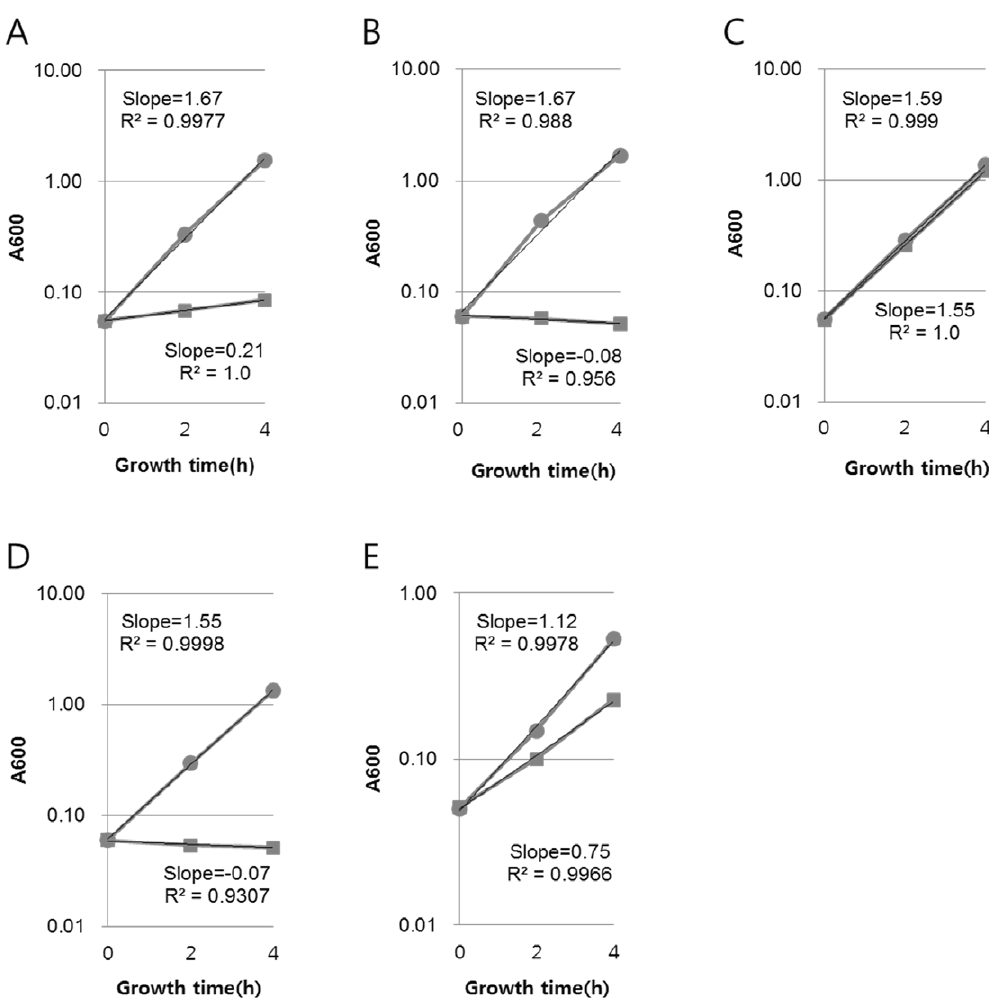
Figure 6. Invivo measurements of DicA binding to Oc. In vivo DNA-binding activity of DicA to Oc was measured by the growth rate of the host cell. The growth rate at 37 u C of the strains HL100/pHL1105 (A), HL100 g dicA /pHL1105 (B), HL100 g dicA /pHL1105/pDicA (C), and HL100/pHL1105* (D) was measured in LB medium (circle) and in LB containing streptomycin (rectangle). Growth rate was determined from the slope of the fitted curve of the bacterial growth measured by OD 600 . The regression coefficient for the fittingindicated that all the fittings are statistically significant. The growth rate of HL100/pHL1105 was also measured at 25 u C (E).